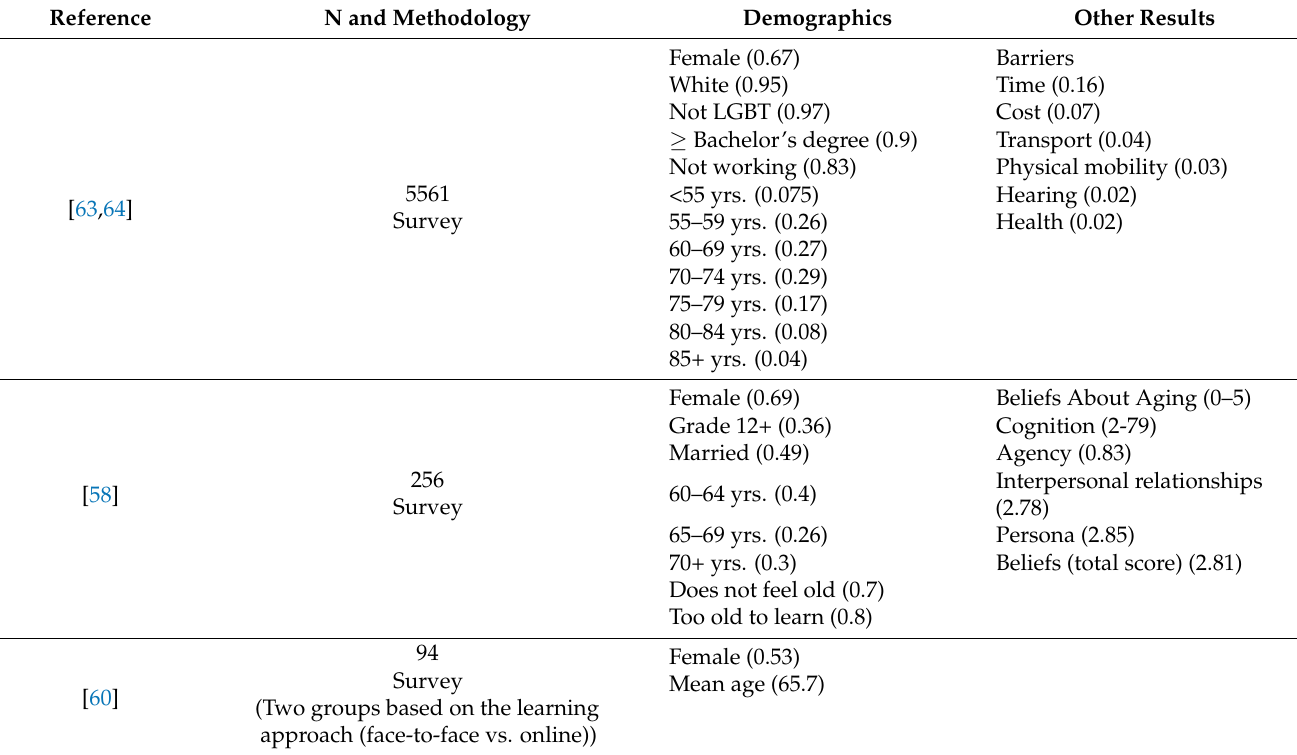
Table 2. Summary of articles focusing on the student (reference, number of people involved in the study, methodology, demographics, and other